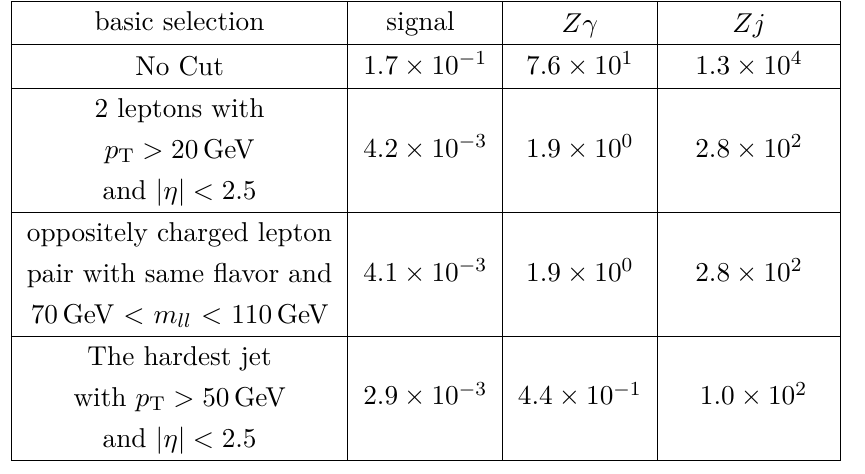
Table 3 . Same as table 1, but for the ALP-strahlung production process pp → Za and the corresponding